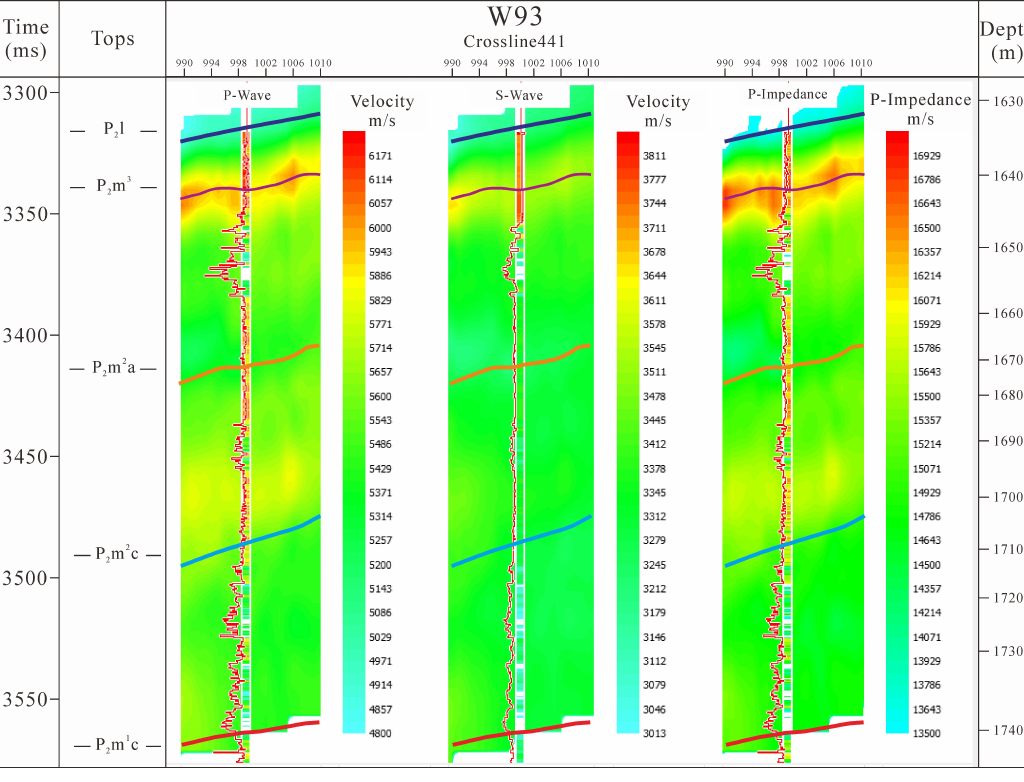
Figure 11. Comparison diagram of longitudinal wave velocity, shear wave velocity, and longitudinal wave impedance with the prestack synchronous inversion profile and logging